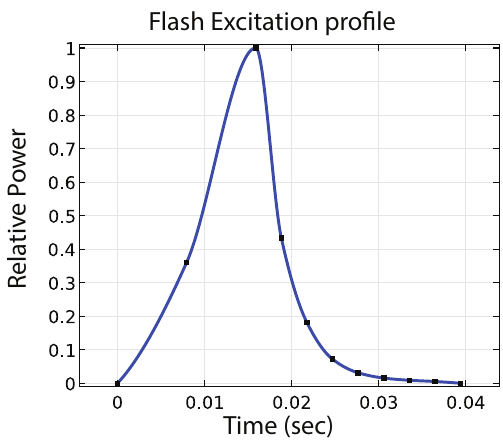
Figure 5. A Xenon flash excitation source output of 6.4 kJ.